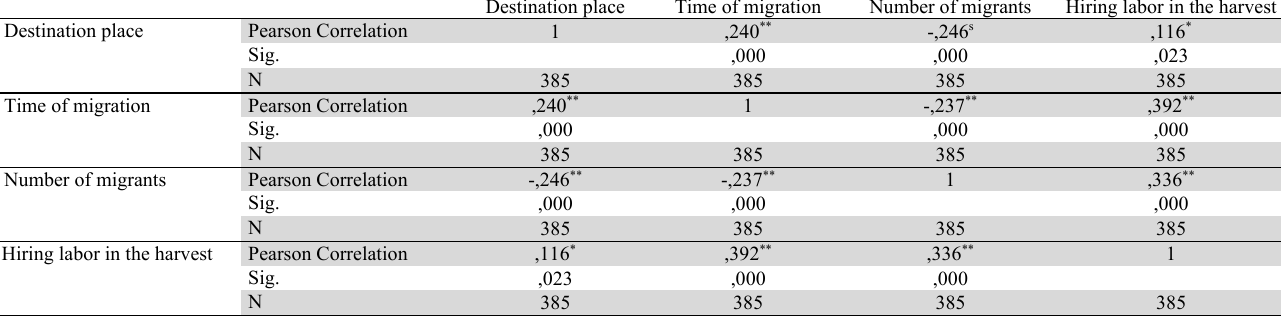
Correlation matrix between factors of migration characteristics and household hiring Destination place Time of migration